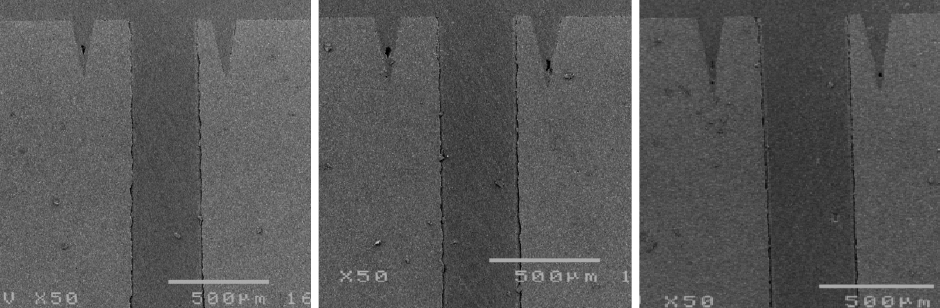
Figure 11. Cross sections of three samples unsuccessfully trimmed with a donut-type laser trimming strategy.